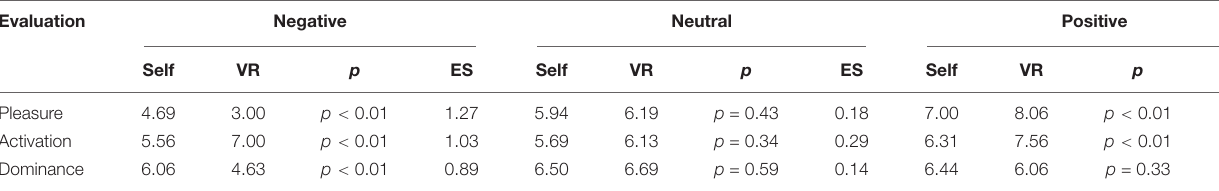
TABLE 2 | Average score and statistical test results of Self-Assessment Manikin (SAM). Evaluation Negative Neutral